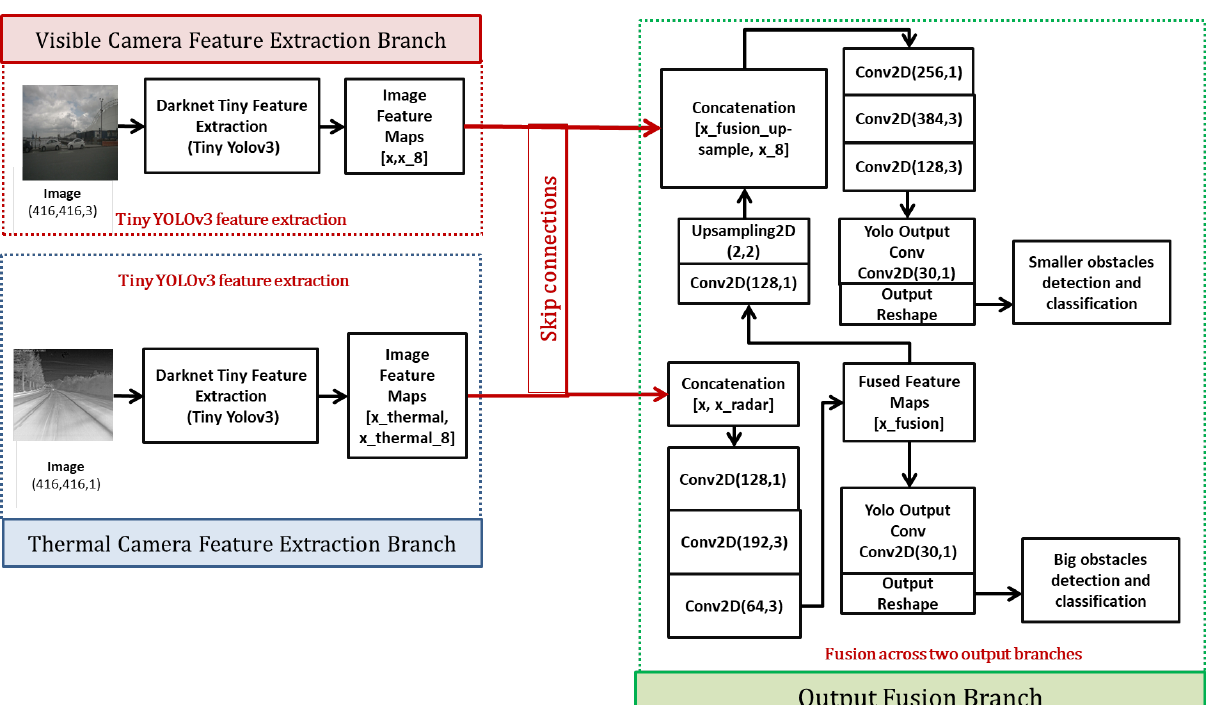
Figure 5. An overview of the TVNet